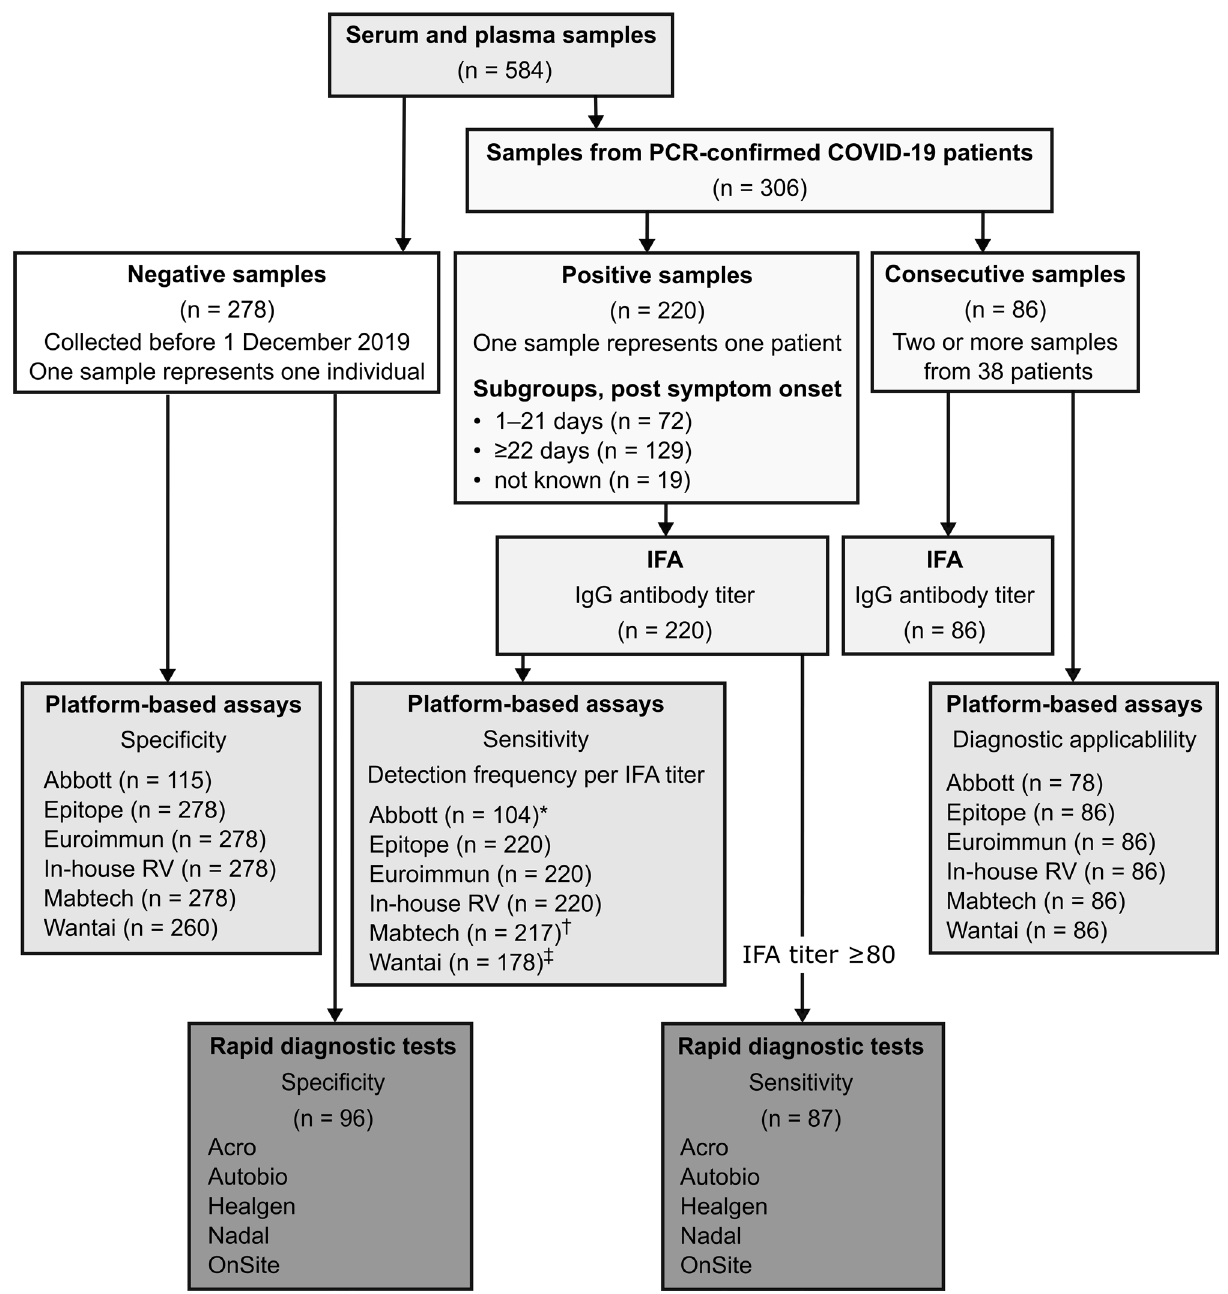
Figure 1. Schematic overview of samples and antibody detection tests. IFA immunofluorescence assay. *32/72 samples collected 1–21 days post symptom onset, 65/129 samples collected ≥ 22 days post symptom onset, and 7/19 samples lacking information regarding elapsed time between symptom onset and sampling. † 126/129 samples collected ≥ 22 days post symptom onset. ‡ 15/72 samples collected 1–21 days and 94/129 samples collected ≥ 22 days post symptom